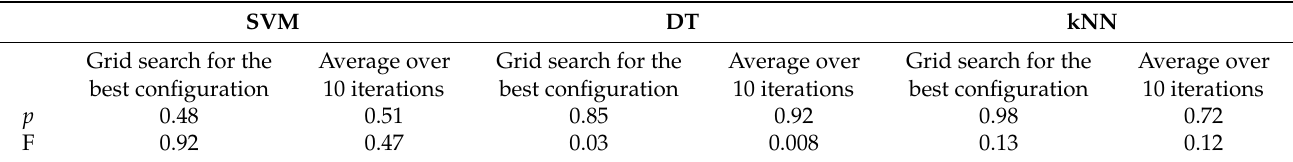
Table 15. p and F values for ANOVA test for independent measures, non-overlapping dataset.